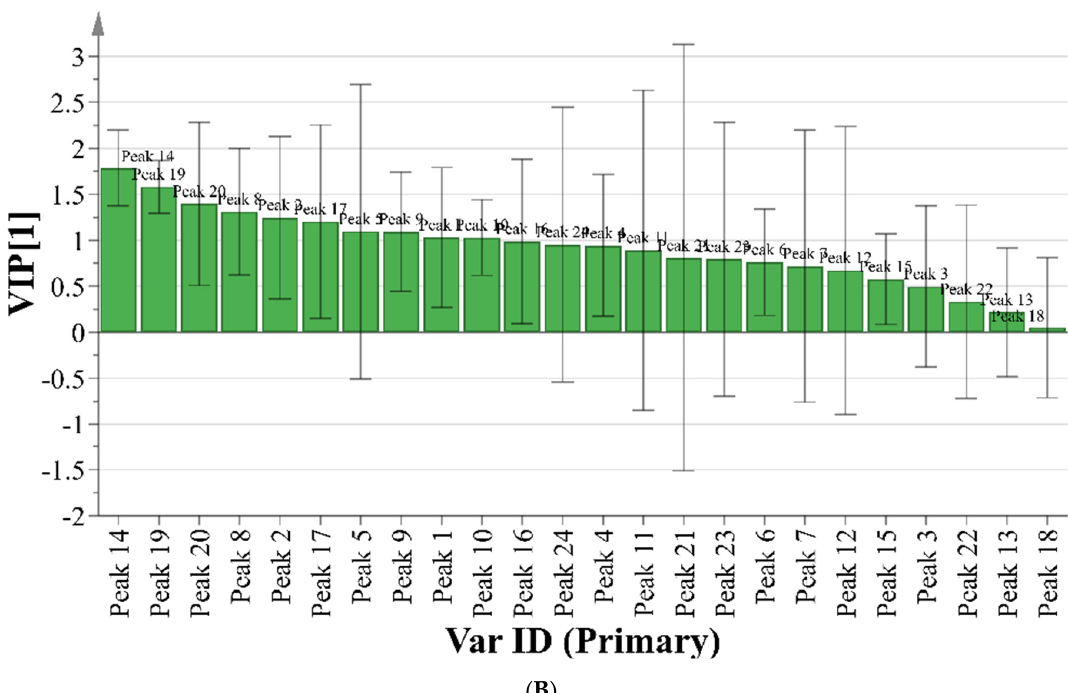
Figure 6. ( A ) Variable importance in projection scores (FRAP assay); ( B ) variable importance in projection scores (ABTS assay). Table 3. Results of normality